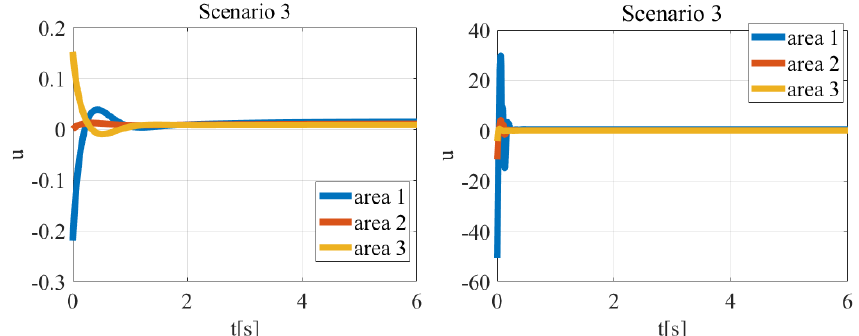
Figure 15. Control signals u ( t ) with LQR ( left figure) and fuzzy controller ( right figure) for different areas—scenario